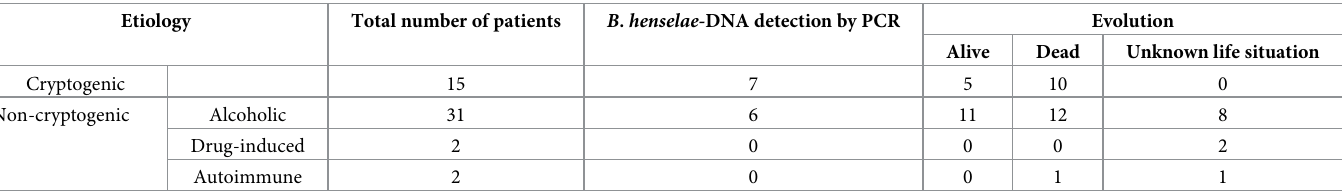
Table 3. Etiology and evolution after at least two years of follow-up of patients with non-viral hepatitis with and without detectable Bartonella henselae -DNA.